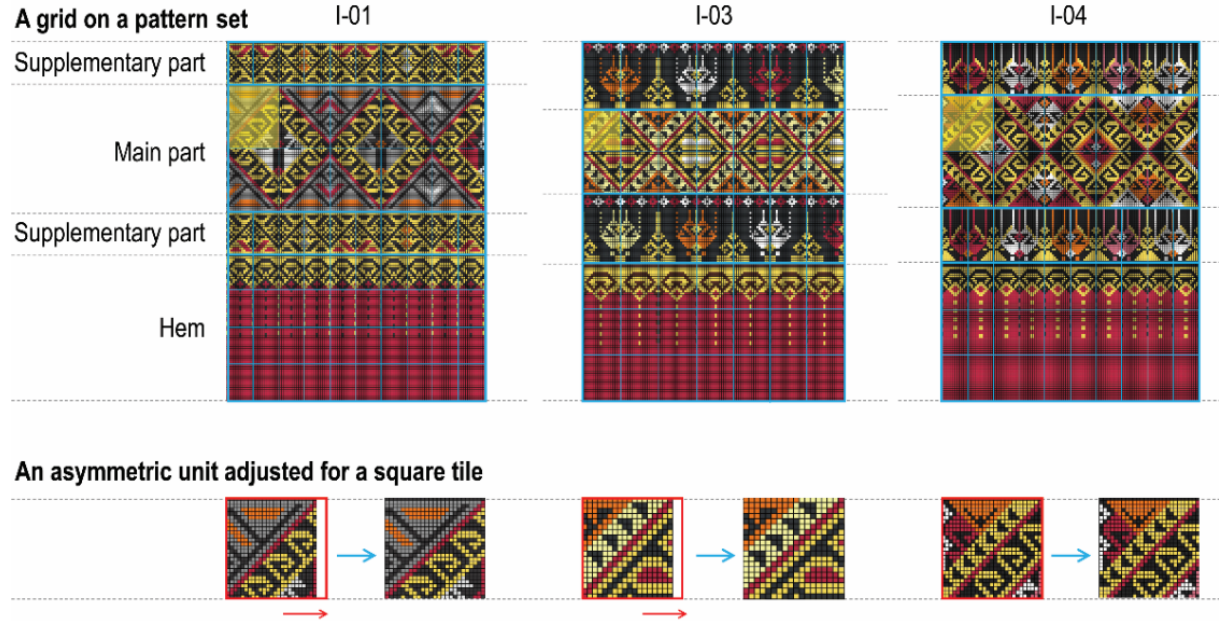
Figure 7. Design derivations from ‘design approach 1’. F1 – F7 represent sets of symbols for the seven frieze groups as indicated in Figure 3. Red arrows indicate tile placement in a horizontal orientation, similarly to translation. (Illustration by Kunkhet and Chudasri).